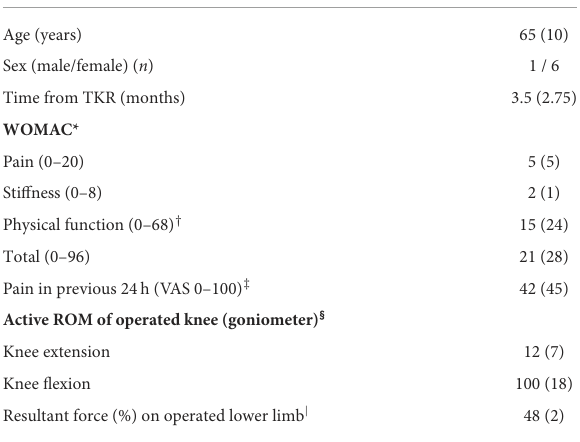
TABLE 3 Participant characteristics ( n =